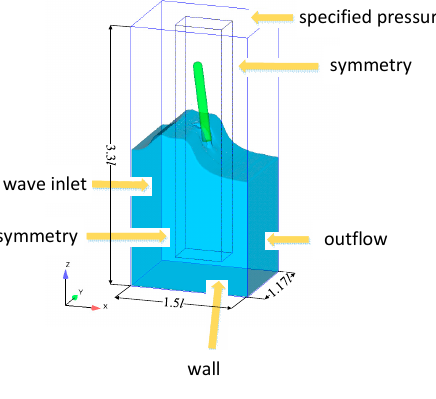
Figure 2. Boundary condition type.